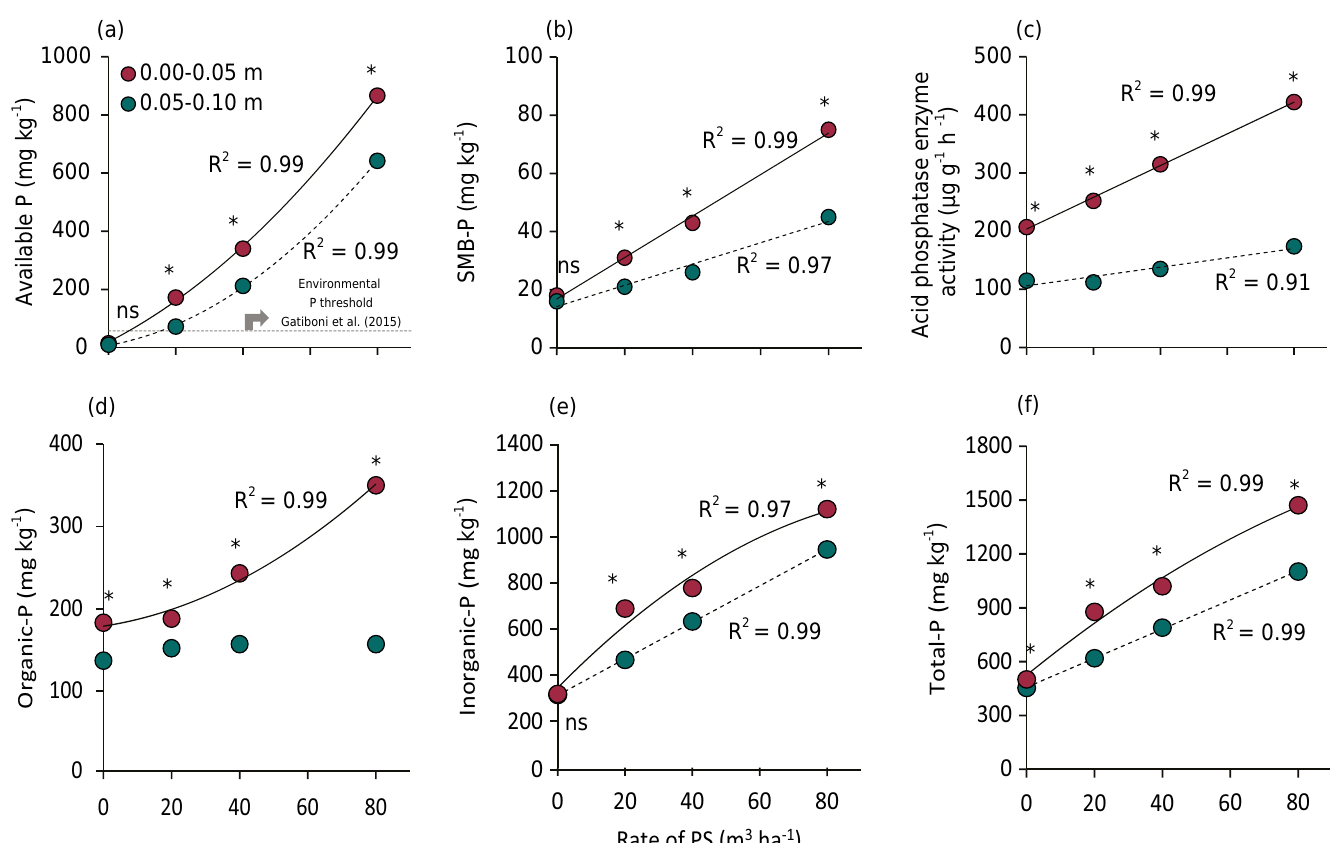
Figure 2. Levels of available P (a), SMB-P (b), acid phosphatase enzyme activity (c), organic P (d), inorganic P(e), and Total-P (f) in soil treated with 19 PS applications over 8 years, in Santa Maria, Rio Grande do Sul, Southern Brazil. Asterisks indicate significant difference (p<0.05) between soil